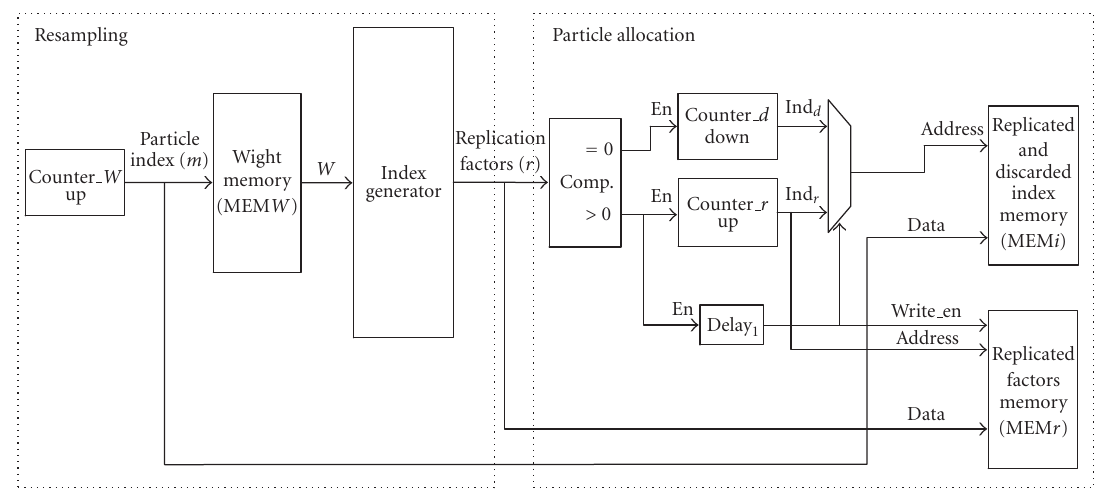
Figure 10: The architecture for the RSR algorithm combined with the particle propagation.